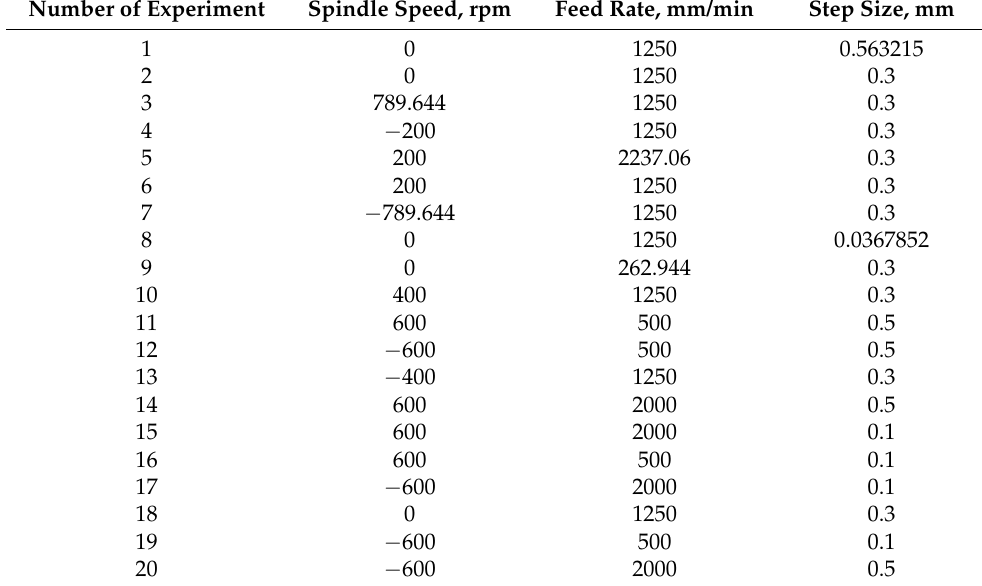
Table 3. Plan of experiments for CCD optimisation.